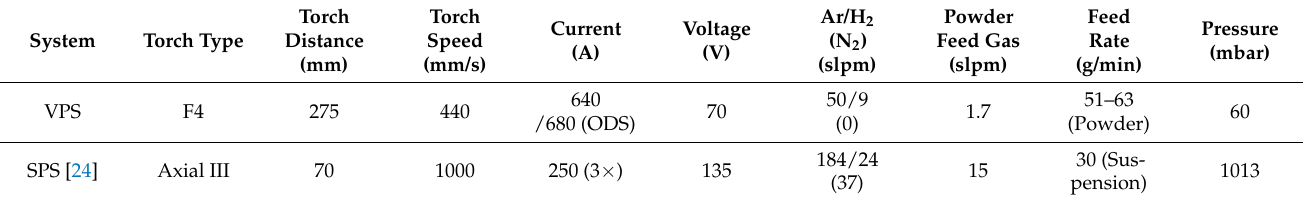
Table 1. Process parameters for thermal